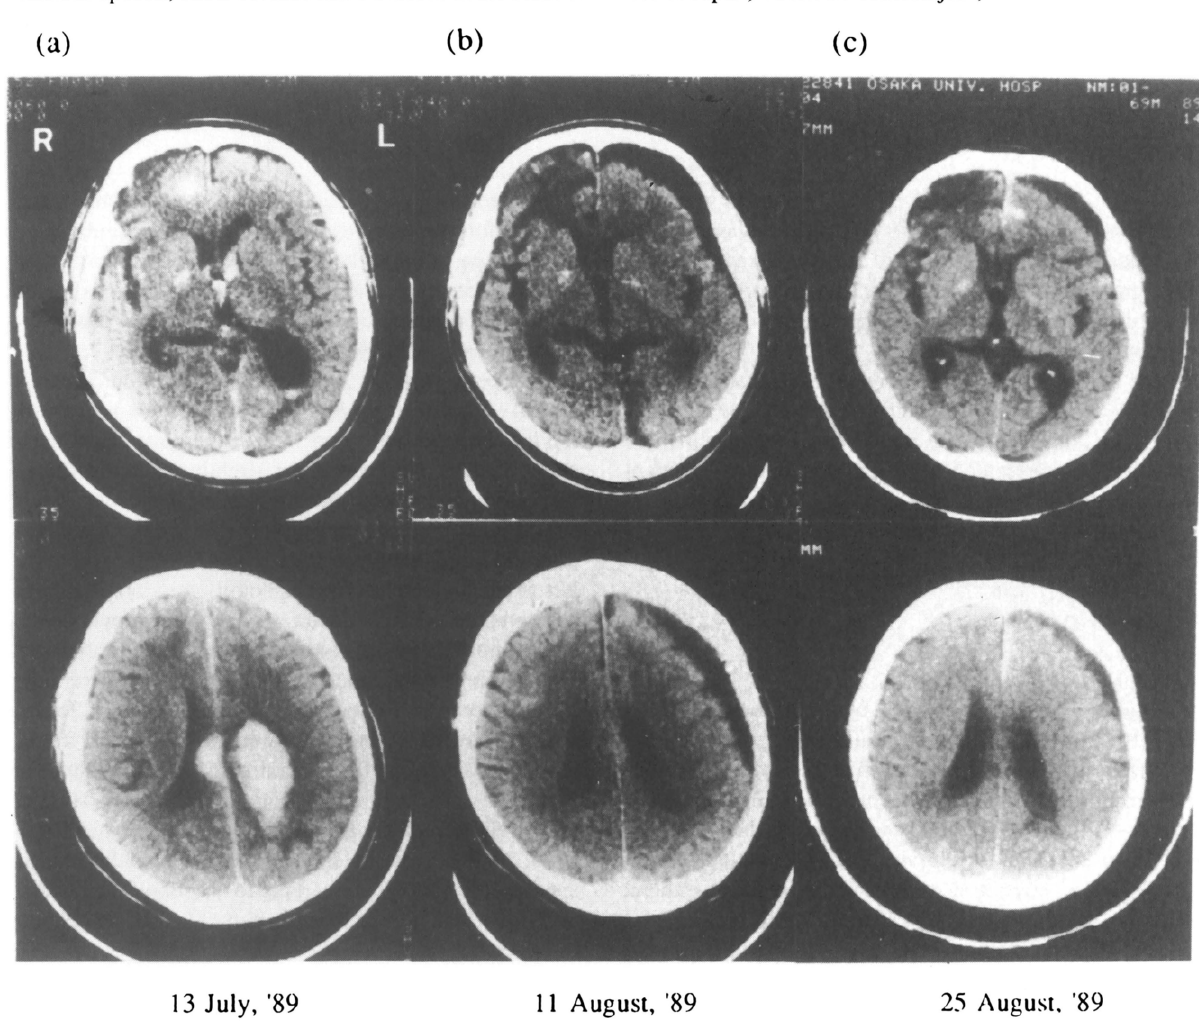
FIG. 1. (a) CT scan on admission showing a small high density spot in the medial aspect of the right frontal lobe invading the cingulate gyrus and high density areas in the deep white matter of the left parietal lobe and the left lateral ventricle. (b) CT scan showing a low density area in the right frontal lobe and subdural effusion in the left frontal area. (c) CT scan showing a new small hemorrhage in the left medial frontal lobe encroaching on the straight gyrus and anteroinferior part of the cingulate gyrus. 242 Behavioural Neurology . Vol 5